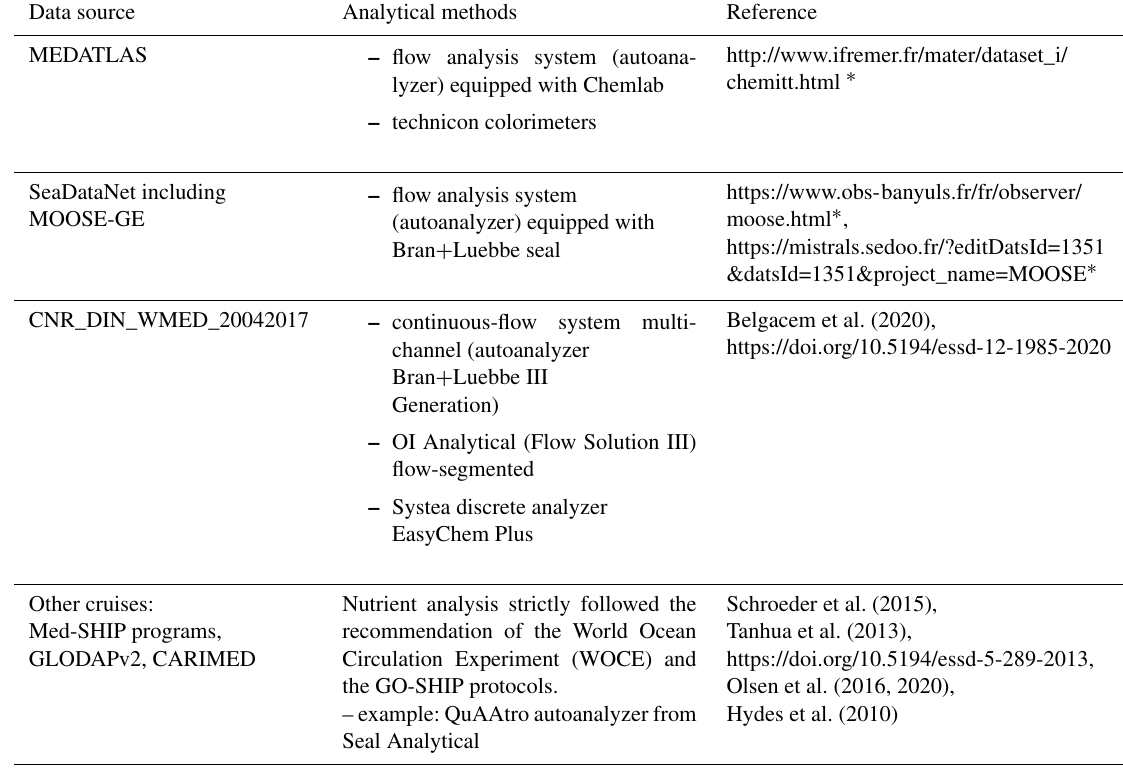
Table A1. Summary table of the analytical techniques and instruments used for nutrient analysis.